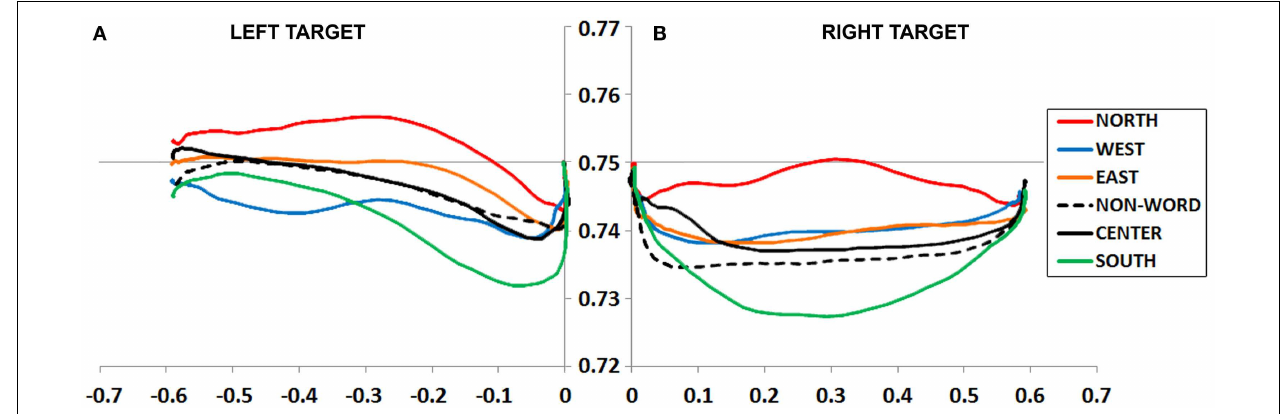
FIGURE 6 | (A,B) Experiment 2 plotted movement trajectory data for the Left (A) and Right (B) target locations, for each of the six PrimeTypes.